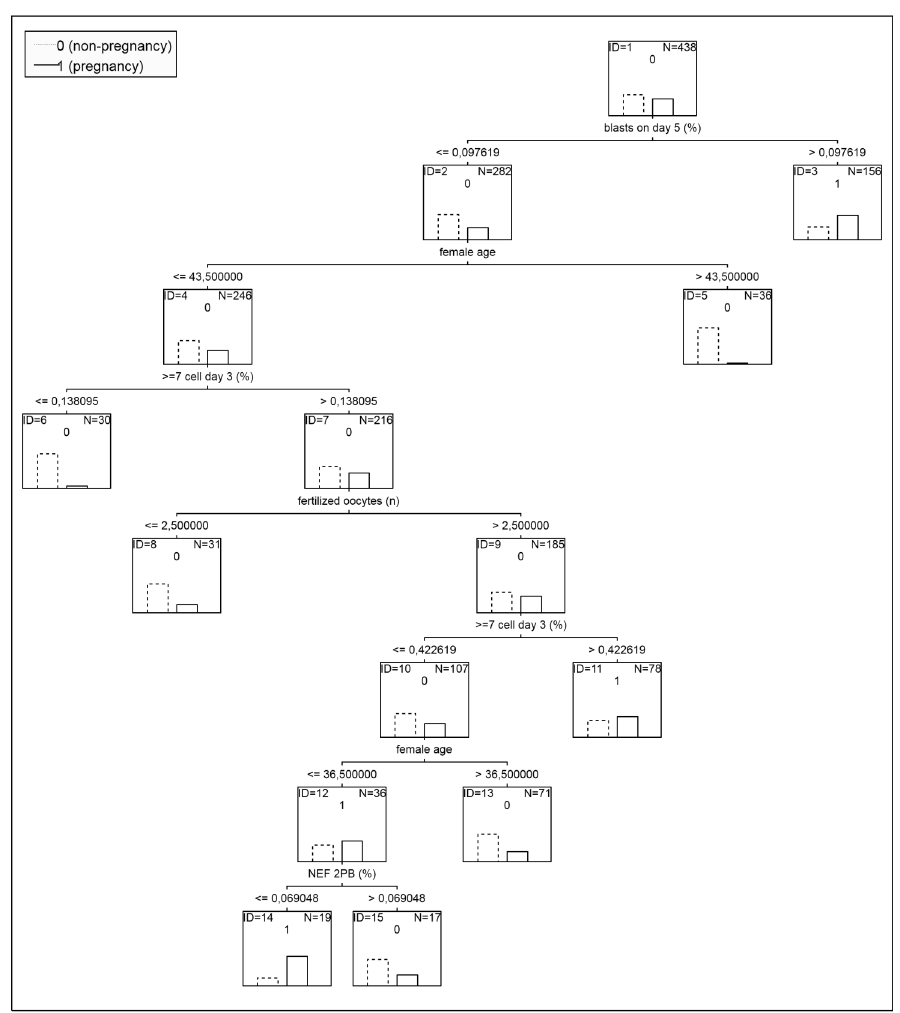
Figure 3. Classification tree constructed with variables relating to the women’s ages, number and quality of embryos and information about the